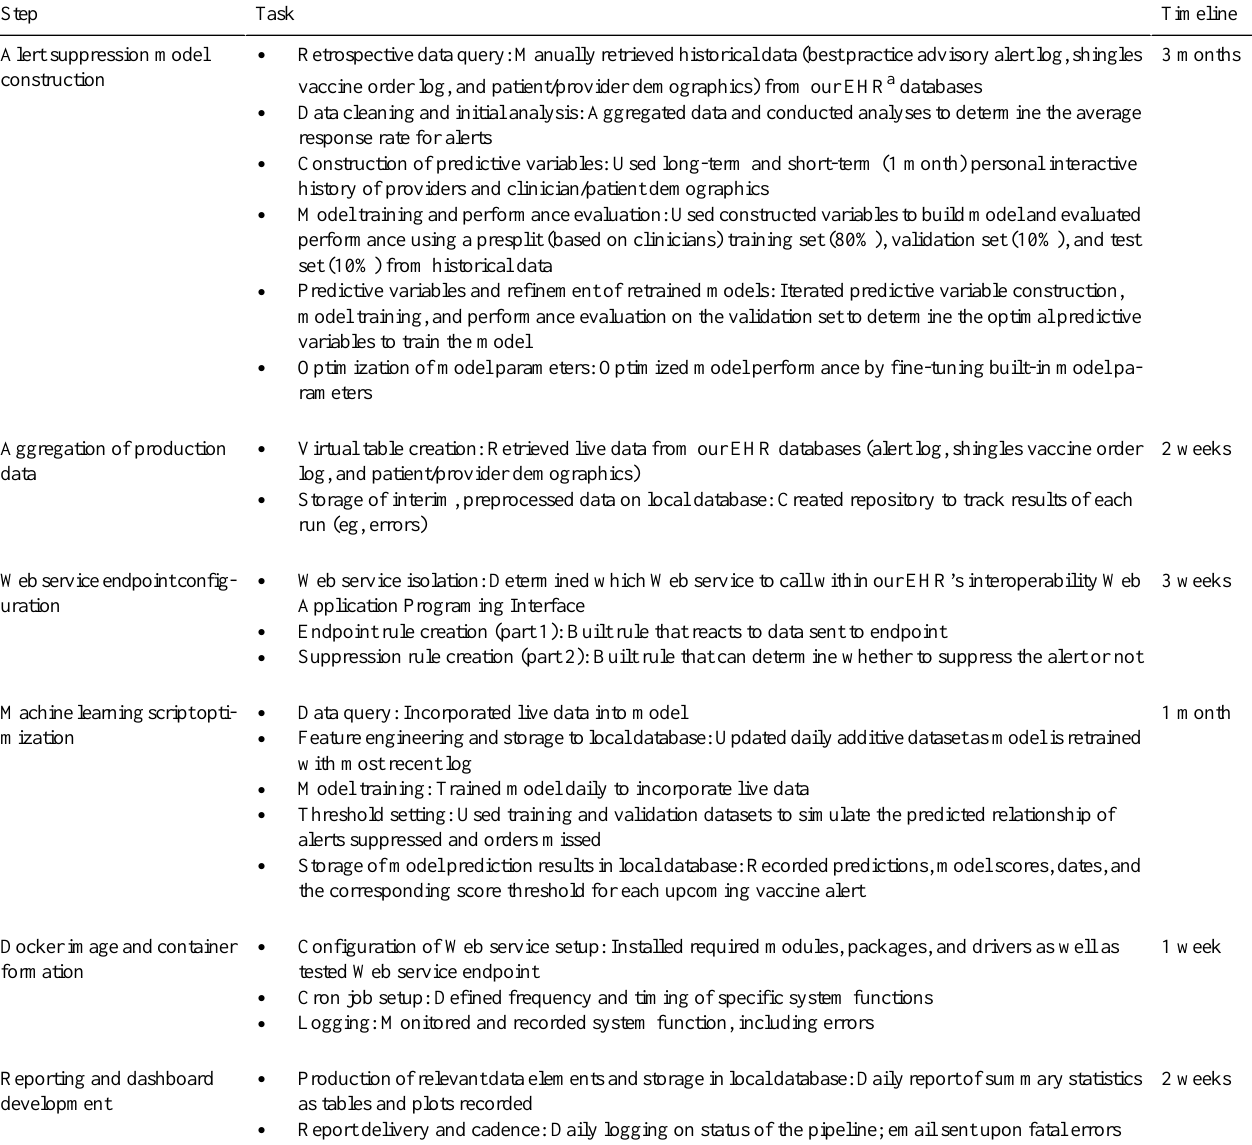
Table 1. Signal-to-noise optimization (SmartCDS) system development.